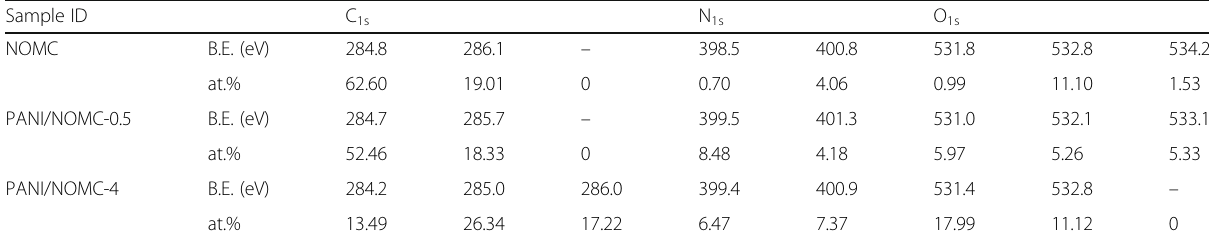
Table 1 The XPS characterization of NOMC, PANI/NOMC-0.5, and PANI/NOMC-4 Sample